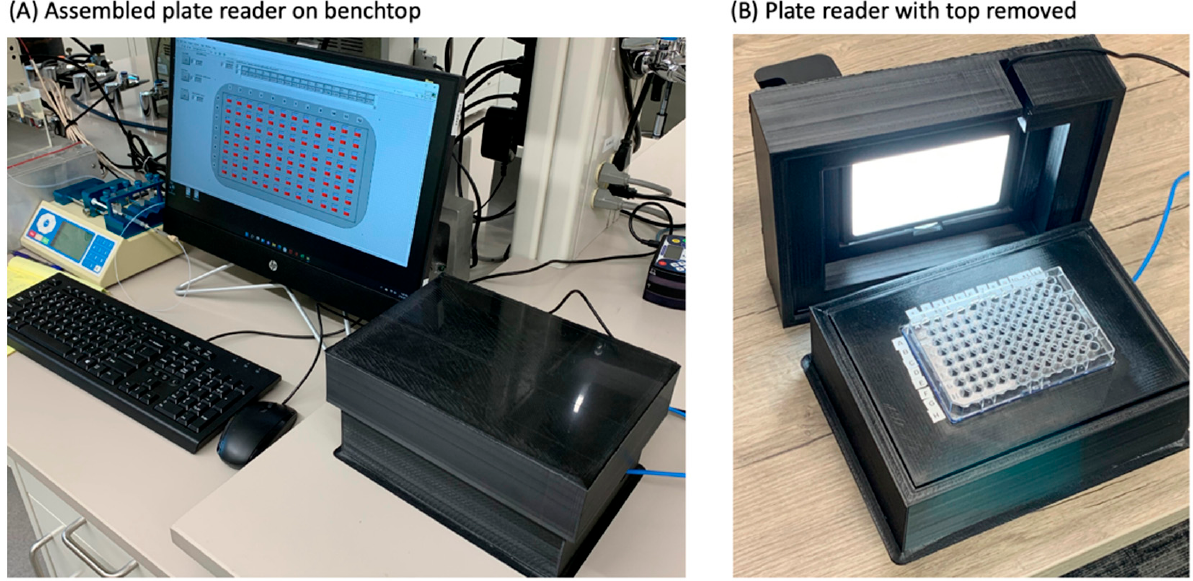
Figure 1. ( A ) Plate reader on lab bench prior to use. ( B ) Plate reader with top removed and no color filter.